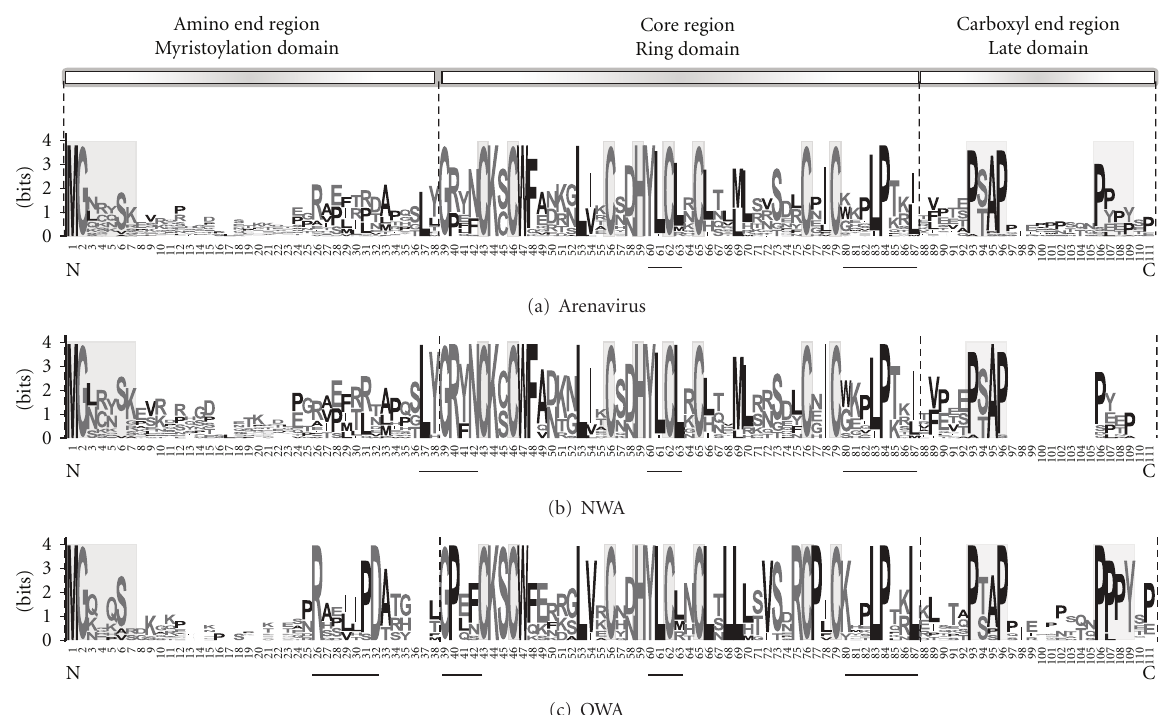
Figure 1: Sequence Logos of Arenavirus Z proteins. The upper diagram shows Z protein and the three regions in which it was divided. The other three are sequence logos, in which the X-axis indicates the relative position of amino acids in the multiple alignments. The length of 111 residues is due to the inclusion of gaps in the multiple alignment. The di ff erent amino acid domains described in the text are shadowed and the newly proposed domains are underlined. (a) Sequence Logo from all selected arenavirus Z proteins. (b) Sequence Logo from selected New World arenavirus Z proteins (ANM; AMAV-BeAn70563, CPXV-BeAn119303, GTOV-CVH-961104, GTOV-VHF-3990, JUNV-MC2, JUNV-Candid#1, MACV-MARU-222688, MACV-9530537, TACV, LATV-MARU-10924, OLVV-3229, PIRV-VAV488, PIRV- 1743, ALLV-CLHP2472, PICV-AN3739, BCNV-A0060209, BCNV-AV-A0070039, WWAV-AV9310135, TAMV-W10777). (c). Sequence Logo from selected Old World arenavirus Z proteins (AVM; LCMV-Clone#13, LCMV-MX, LASV-CSF, LASV-AV, IPPY-DakAnB188, MOBV- Acar3080, MOPV-AN20410, MOPV-Mozambique, Lujo, and